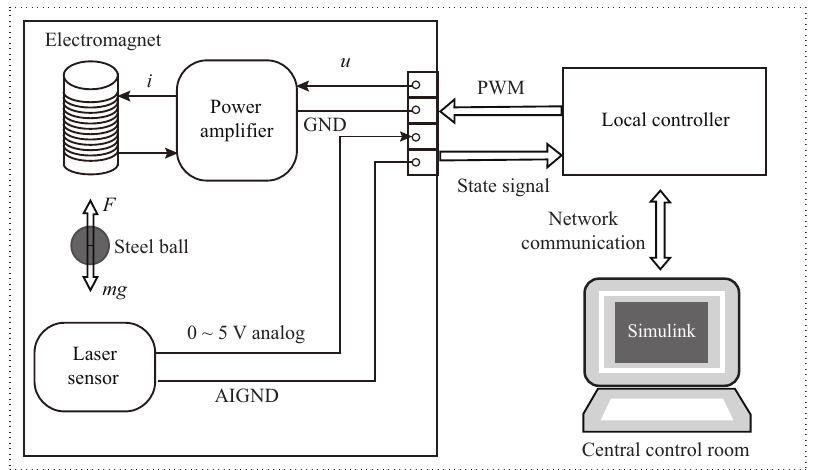
Figure 8. Structure of magnetic levitation ball system.